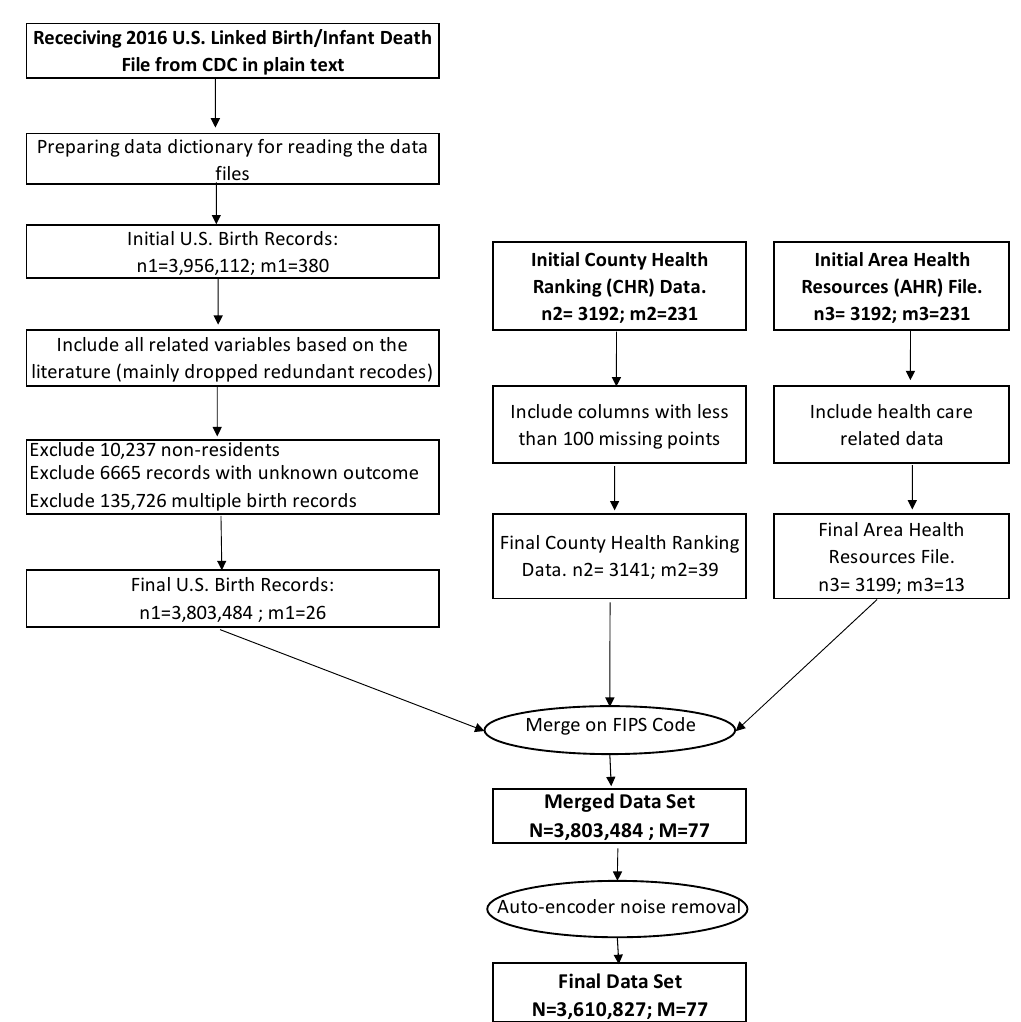
Figure 2. Steps of data preparation.